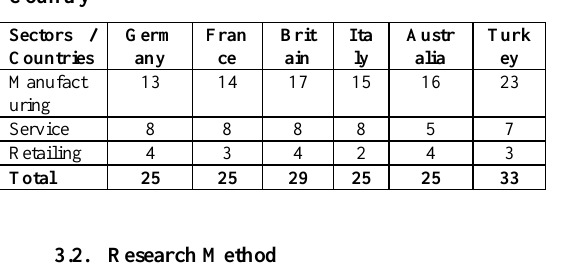
Germ Fran any ce